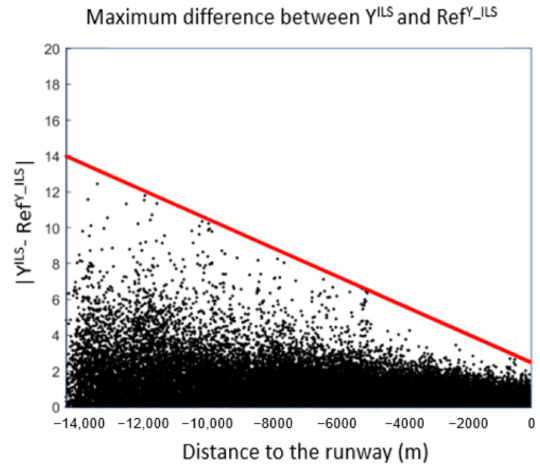
Figure 21. Envelope for ILS using real values for the Y coordinate.